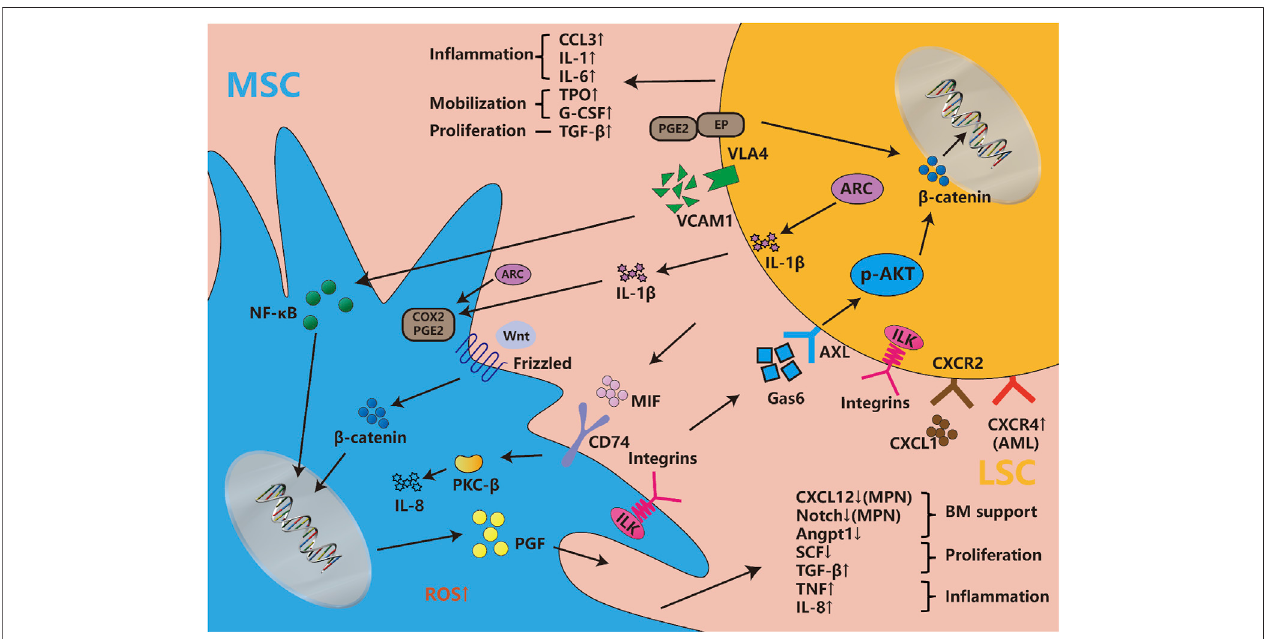
FIGURE2| Cytokines,chemokines and signaling pathways in fl uenceboth LSCsand MSCs.Abundant cytokines and chemokines arereleased byboth LSCsand leukemic MSCs, which are mainly involved with the changes in in fl ammatory factors, proliferation and differentiation-associated cytokines, hematopoietic homeostasis- related chemokines, etc. They involve changes in multiple signaling pathways, such as the newfound VCAM1-VLA4-PGF/NF- κ B, Gas6-AXL/p-AKT/ β -catenin, MIF- PKC β /IL-8, etc. Meanwhile, WNT/beta-catenin, Notch/Jagged, and other pathways are also disordered in leukemic niche. The integrin, considered to be widely expressed in both LSCs and MSCs, is involved in a series of classical pathways. The classic signaling pathway involved in cell proliferation and stemness such as MEK/ ERK, JAK/STAST3, PI3K/AKT, etc., are not described in the fi gure, but they induce many changes in both types of cells.